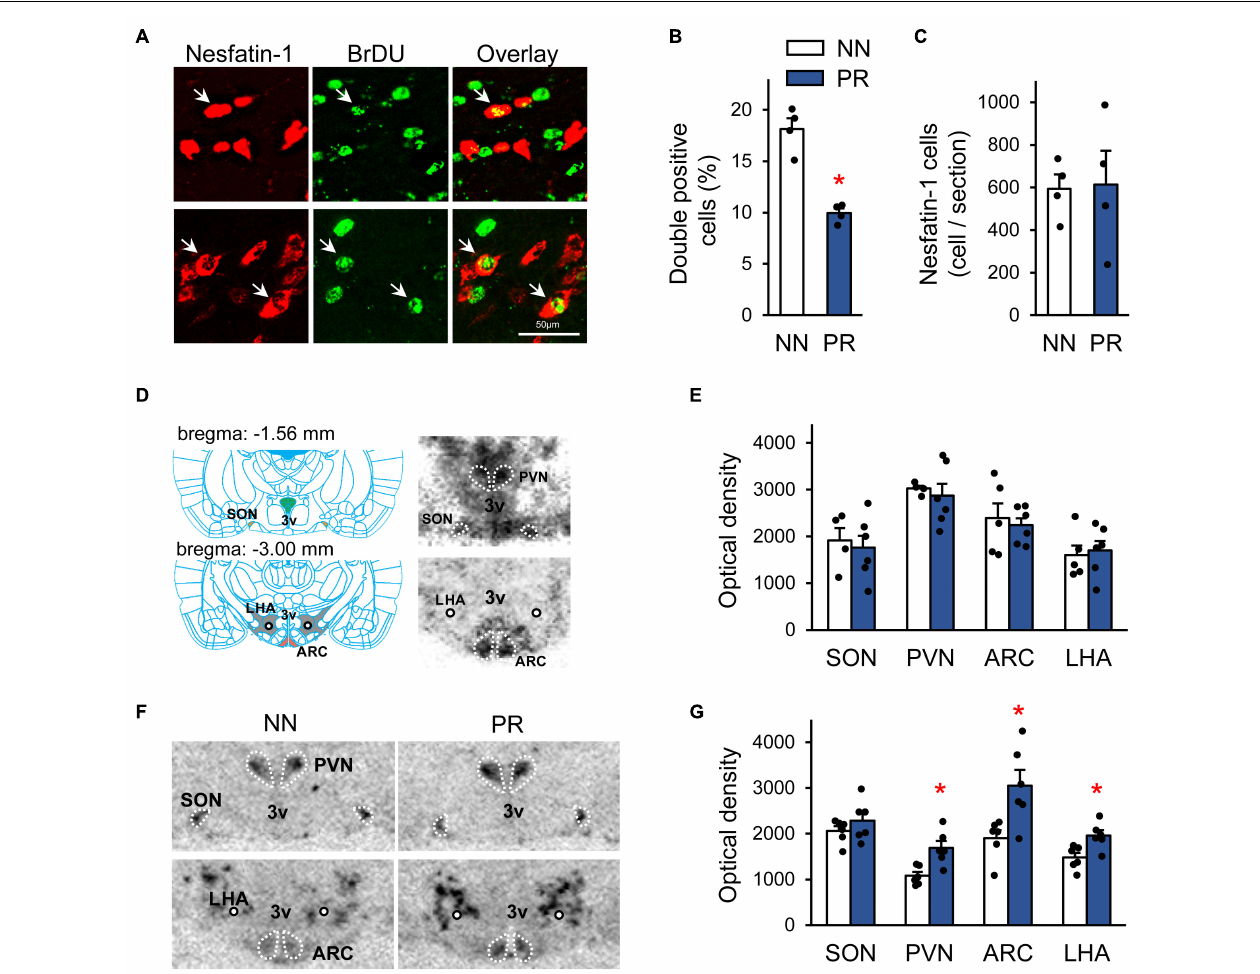
FIGURE 3 | Characterization of the peripheral and central nesfatin-1 system. (A) Birth dating of nesfatin-1 neurons by bromodeoxyuridine (BrDU) at the embryonic day 13 (E13). Confocal microscopic images showing nesfatin-1 and BrDU double-labeled cells (arrows) in the hypothalamus of a NN rat. The immunostaining was performed using coronal hypothalamic sections of adult offspring. (B) Percentage of nesfatin-1 cells generated at E13 (BrDU and nesfatin-1 double-labeled cells) in the hypothalamus. Two-way RM-ANOVA, effect of phenotype F ( 1 , 2 ) = 71.83, * p = 0.014, n = 2 animals and 4 sections/group. (C) The number of hypothalamic nesfatin-1 positive cells in adults. n = 4 animals/group. (D) Left: Schematic (Paxinos and Watson, 2007) showing the location of the investigated hypothalamic nuclei in coronal brain sections. The rostro-caudal distance from the bregma level is indicated for each section. ARC, arcuate nucleus; PVN, paraventricular nucleus; SON, supraoptic nucleus; LHA, lateral hypothalamic area; 3V, 3rd ventricle; circle, fornix. Right: Detection of NUCB2/nesfatin-1 mRNA by radioactive in situ hybridization technique in the investigated areas in neonatal rats. Autoradiographic images (NN rat) of coronal sections. The darker the shades of gray, the stronger the signal. (E) Bar graph showing NUCB2/nesfatin-1 mRNA levels in the investigated nuclei in neonates, n = 4–6. (F) Autoradiographic images showing NUCB2/nesfatin-1 mRNA expression in adult NN and PR rats. Note the enhanced signal intensity in most of the measured nuclei in the PR rat. (G) Bar graph showing NUCB2/nesfatin-1 mRNA levels in the investigated areas in adults. Student’s t -test, or Mann-Whitney U -test, NN vs. PR * p < 0.05, n = 6. Bar graphs show means ±